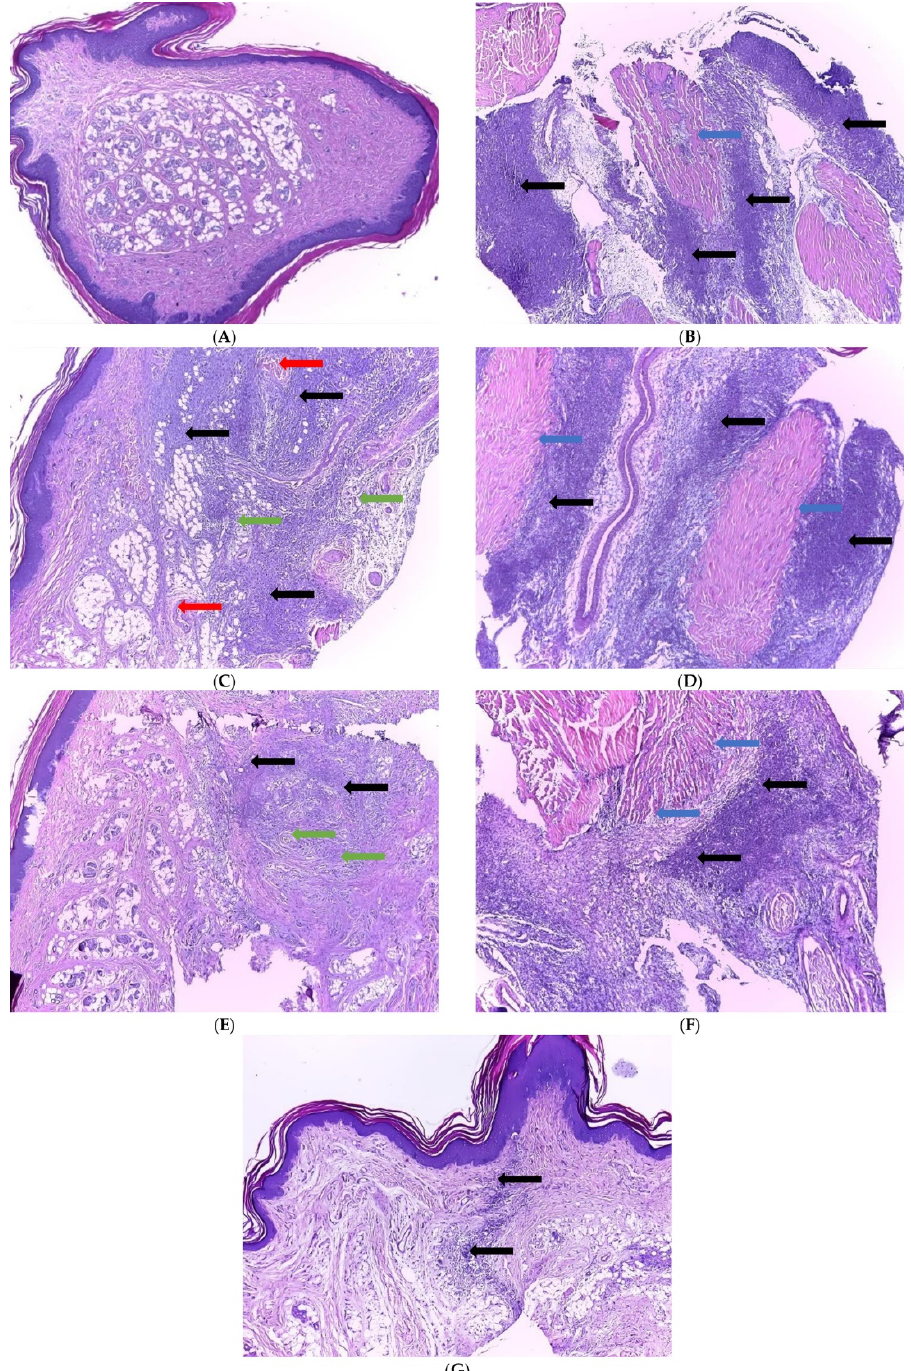
Figure 9. Histopathological examinations of the fragments from right-hind paw: ( A ) C-normal architecture of dermis and hypodermis of the plantar surface of the foot; ( B ) AI-acute purulent inflammation in the dermis, hypodermis ( black arrow ), with an extension on the underlying muscular tissue ( blue arrow ); ( C ) AID-dermis and hypodermis with signs of acute purulent inflammation ( black arrow ), micro-abscess formation ( green arrow ), and micro-thrombi ( red arrow ) in several vascular lumens; ( D ) AIcC200-acute purulent inflammation in the dermis, hypodermis ( black arrow ), with the extension on the underlying muscular tissue ( blue arrow ); ( E ) AIcC200D-inflammation focalized in the hypodermis ( black arrow ) associated with microabscess formation ( green arrow ); ( F ) AInC200-acute purulent inflammation in the dermis, hypodermis ( black arrow ), with an extension on the underlying muscular tissue ( blue arrow ); ( G ) AInC200D-reduced level of inflammation on dermis and hypodermis ( black arrow ).